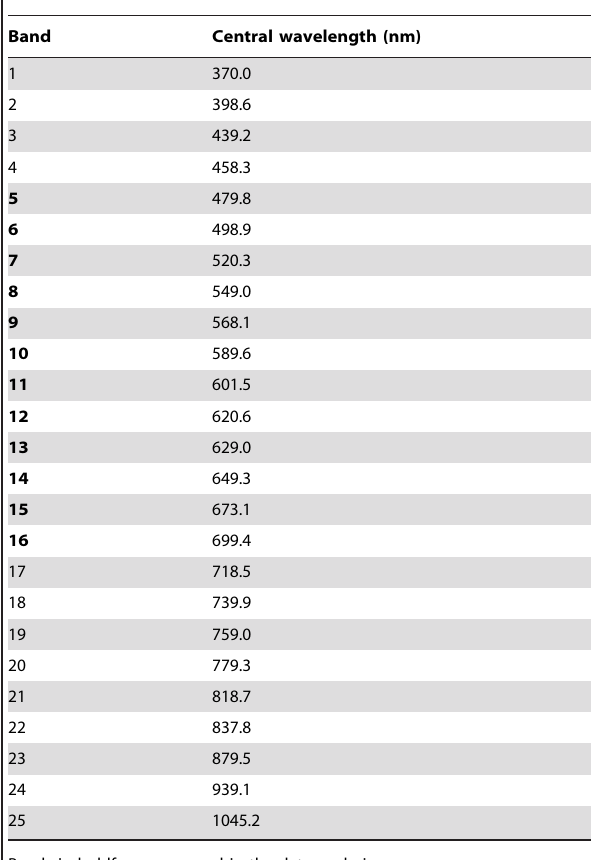
Table 1. Central wavelengths of the CASI bands.